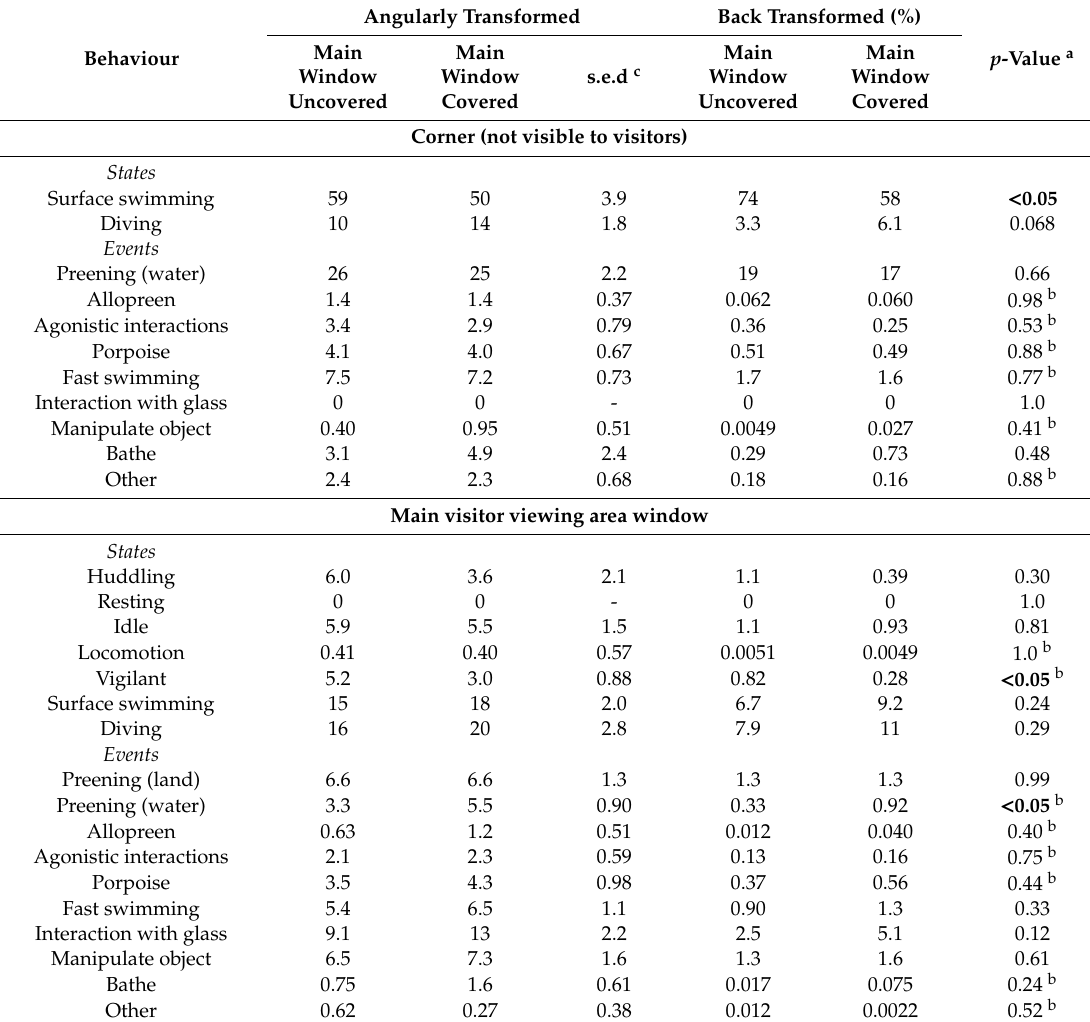
Table 6. The e ff ect of treatment on the proportion of visible penguins in each behaviour (states and events) in the area near the main visitor viewing area window and the ‘Corner’. Data were angularly transformed. Any statistical significance ( p < 0.05) are